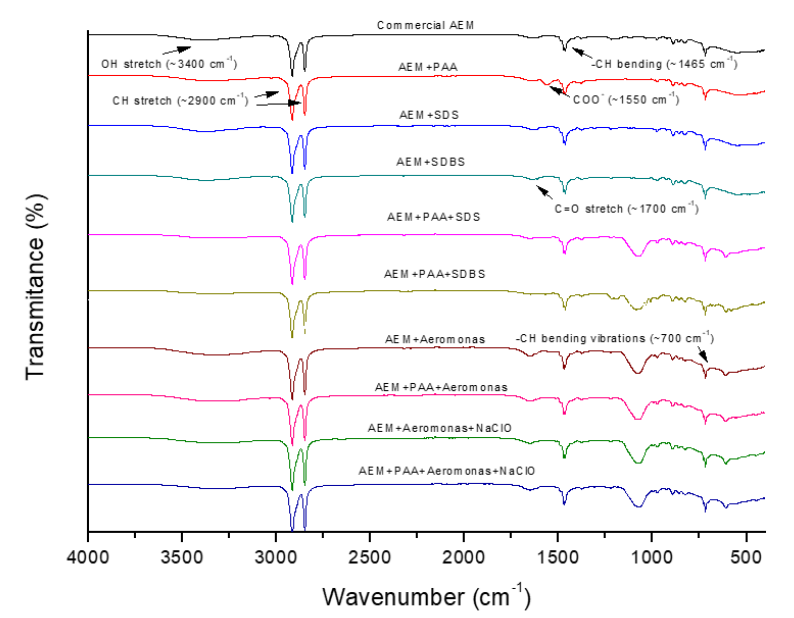
Figure 3. ATR-FTIR spectra of the AEMs. The results of the membranes with Aeromonas are from the first batch.